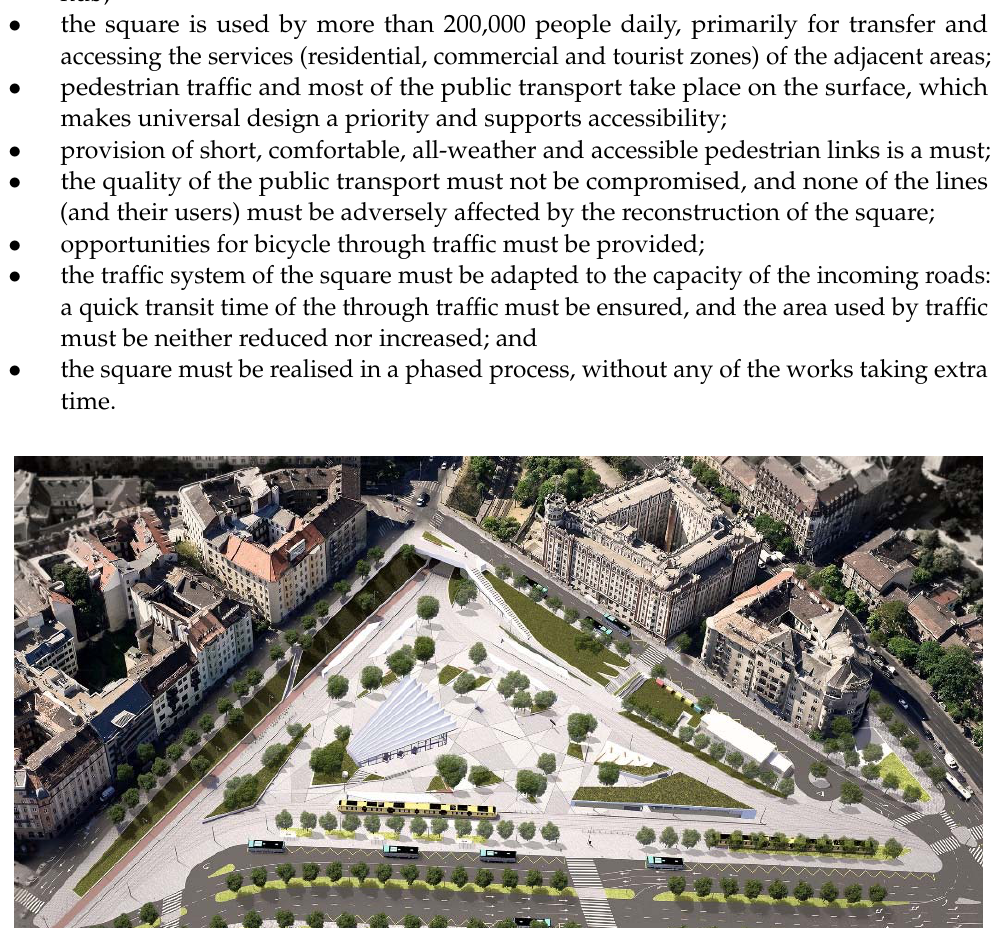
Figure 6. The two monumental units of the exposed concrete relief map ( left ), and a detail of the map ( right ) with the 1823 depiction of Széll Kálmán Square. (Photos by the authors, 2019). The new Ditrói Mór Street promenade (Design: Lépték Terv Kft.) could form a bay along the Szent István Boulevard, providing leisure opportunities in the vicinity of the intensive traffic of the boulevard. Ditrói Mór Street is the entrance area of the theatre called Vígszínház, a meeting point before and after the plays, serving also as a site for open-air performances and exhibitions. It is the unique design features that make this project special. The request of the client was a traditional design symbolising the world of operettas characteristic to the rep- ertoire of Vígszínház, inspired by Hungarian folk motives. According to the concept of the designer, due to the characteristics of the urban environment of the planning site, which is one of the most cosmopolitan districts, and Eclecticism dominating its architecture, it was possible to fulfill this request only in an abstract way. Thus, the main idea of the appear- ance was based on the motives of Kalocsa embroidery with a simplified, minimalist and functionalist interpretation. The choice of materials was inspired by the atmosphere of